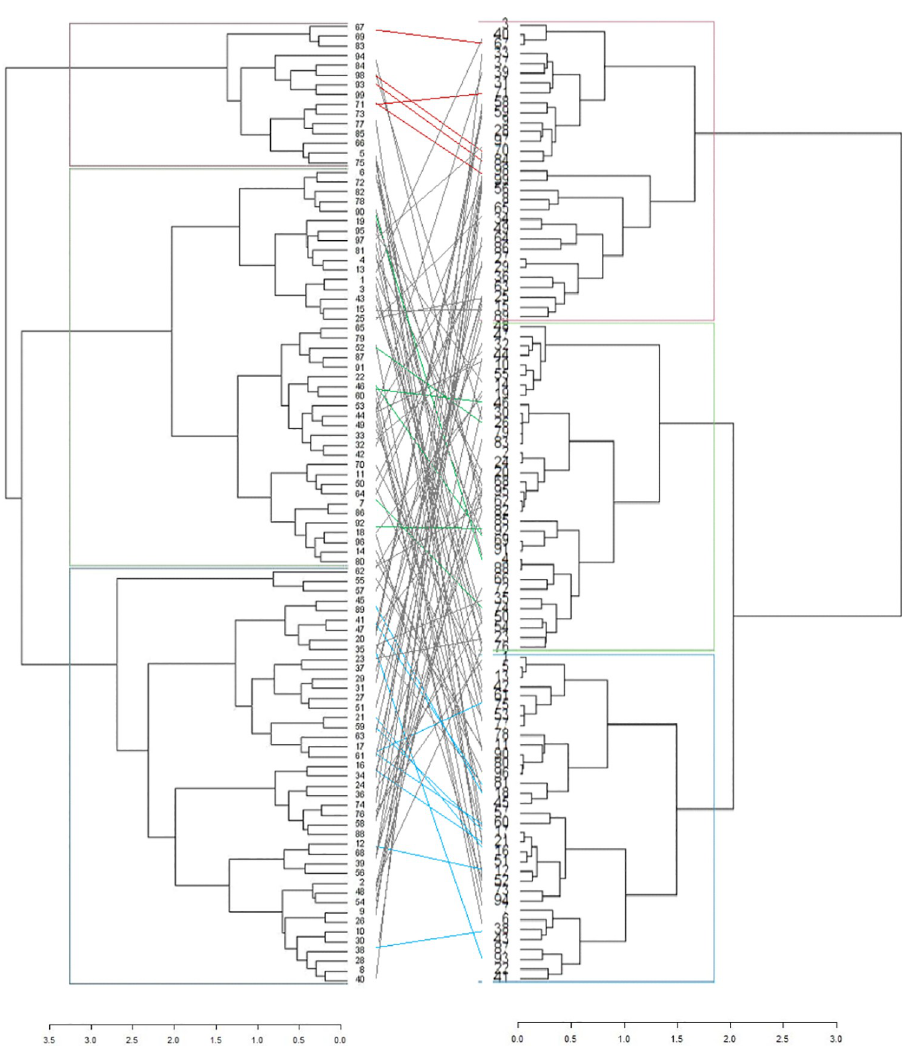
Fig 7. Tanglegram showing comparison of phenotypic and genotypic dendrograms. See codes of genotypes in S5 Table.